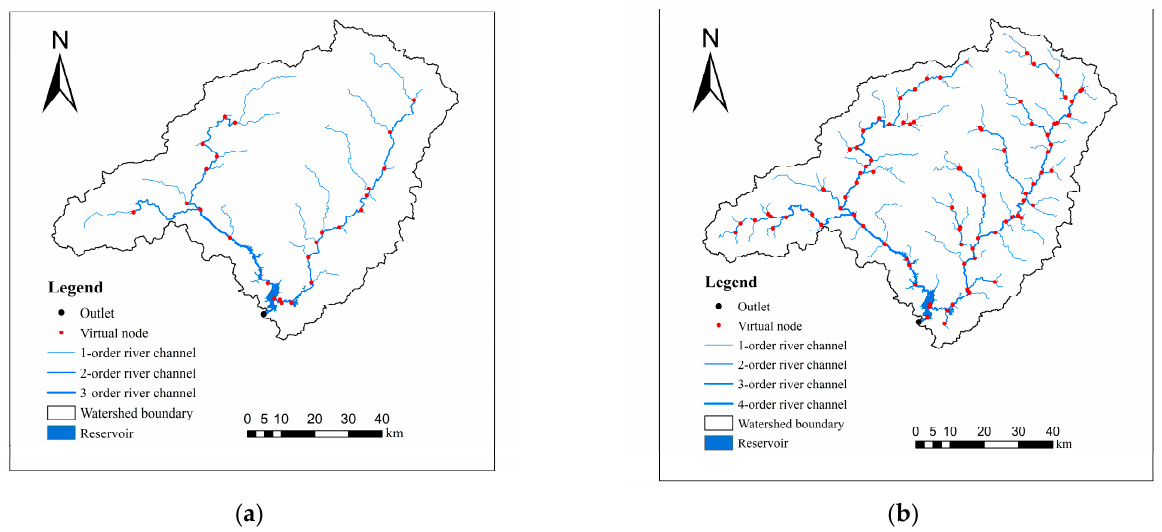
Figure 3. Liuxihe model structures with different channel classifications. ( a ) The model structure under a three-level channel and ( b ) the model structure under a four-level channel.